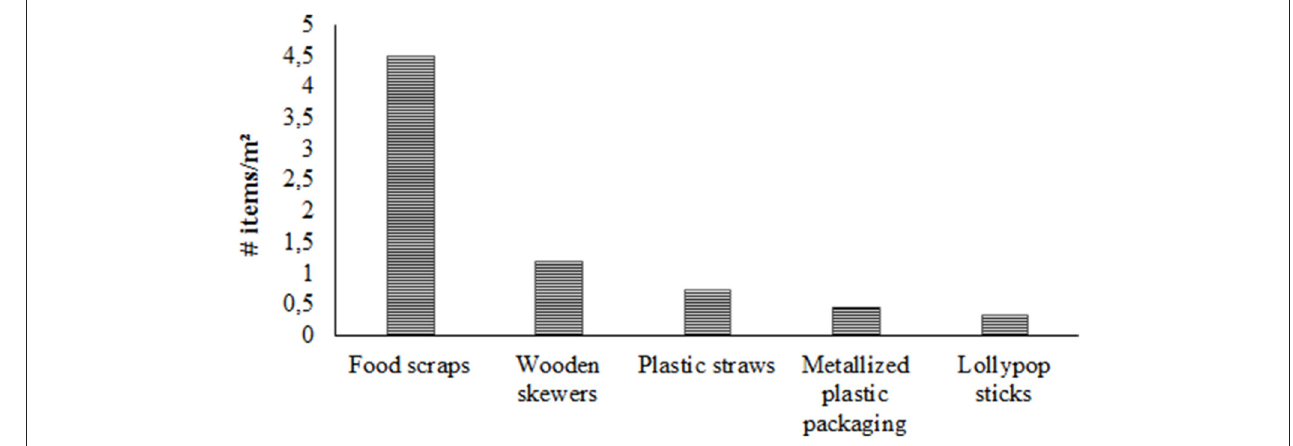
FIGURE 5 | Most abundant beach-user related litter items.